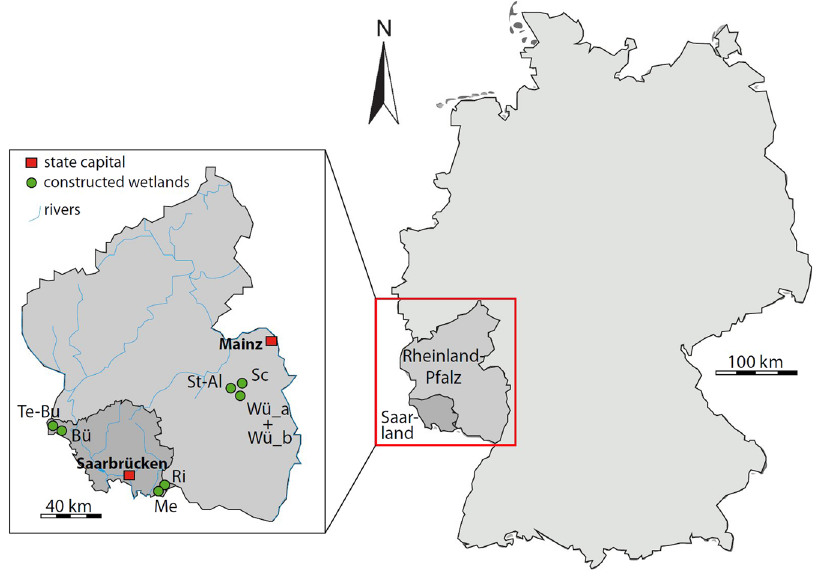
Figure 1. Location of constructed wetlands investigated in this study in southwestern Germany. Bü: Büschdorf; Me: Medelsheim; Ri: Riesweiler; Sc: Schneebergerhof; St-Al: St. Alban; Te-Bu: Tettingen-Butzdorf; Wü_a: Würzweiler 1; Wü_b: Würzweiler 2. This figure, inclusive of the map, was created by Silke Mayer using Adobe Illustrator